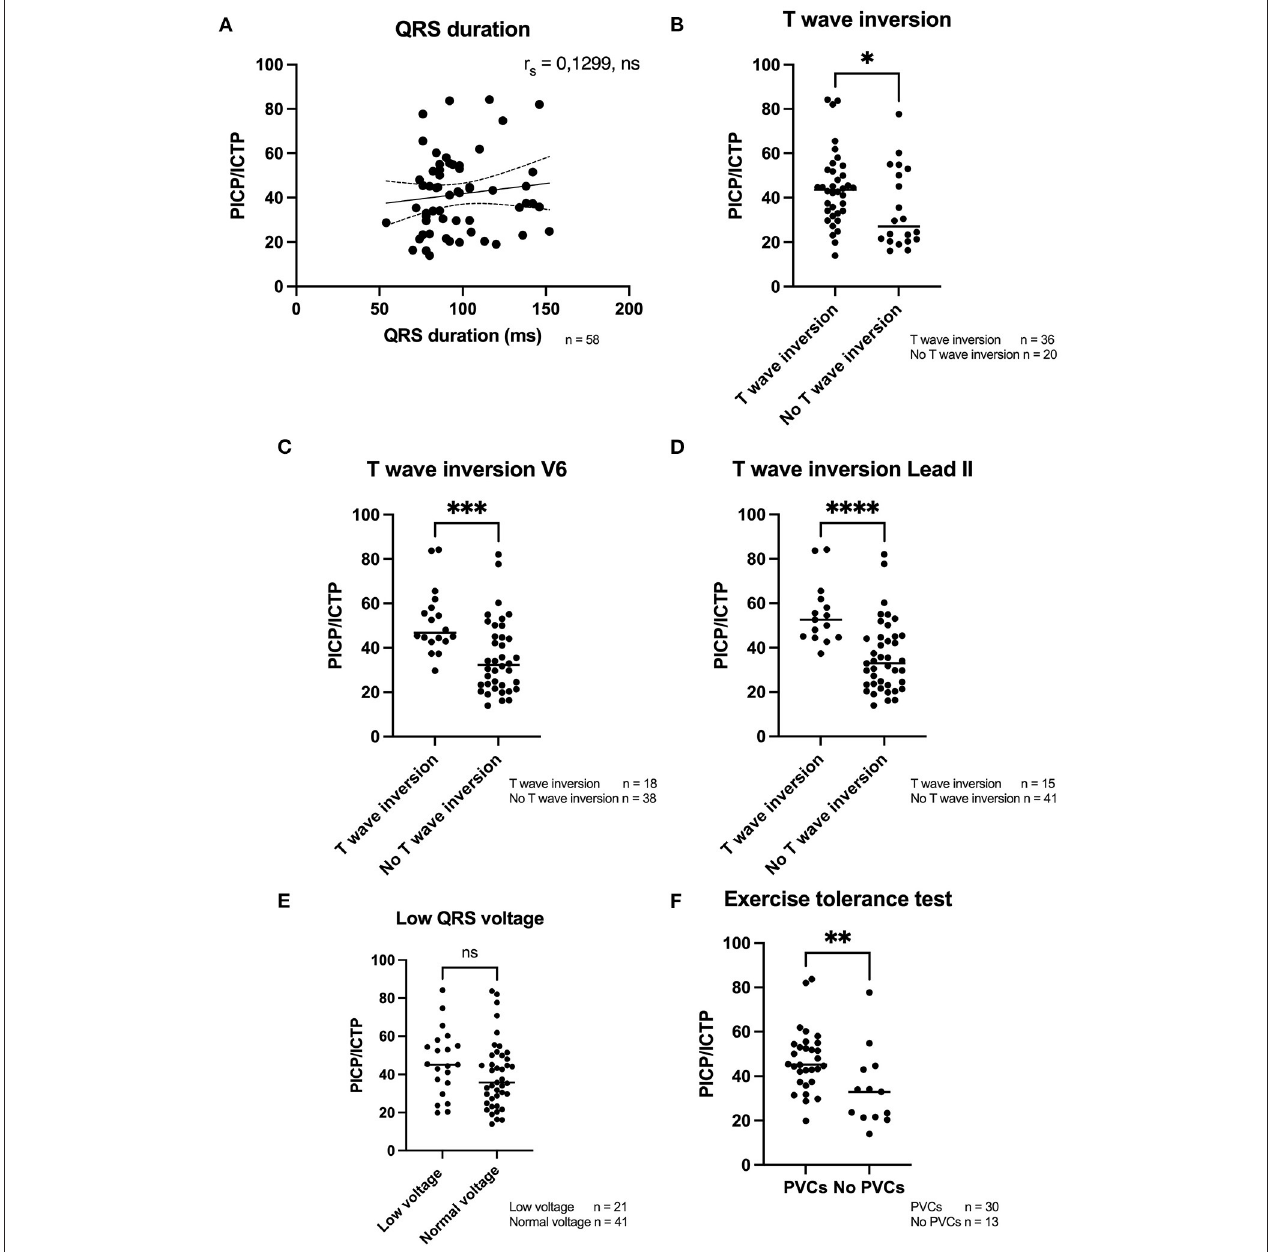
FIGURE 2 | Fibrosis biomarkers in relation to electrical parameters. (A) A weak positive correlation was found with QRS duration ( n = 58). (B–D) A significant higher PICP/ICTP ratio was found when a T wave inversion was present, overall, but especially when detected in lead V4–V6 and lead II, III, and aVF. (E) No difference was found in the ratio of fibrosis biomarkers and the presence or absence of low QRS voltages. (F) PICP/ICTP ratio was significantly higher when PVCs were detected during an exerice tolerance test. PVCs, premature ventricular contractions; PICP, procollagen type I carboxy-terminal pro-peptide; ICTP, C-terminal telopeptide collagen type I; rs, Spearman’s rho. **** p < 0.0001, *** p < 0.001, ** p < 0.01, * p <